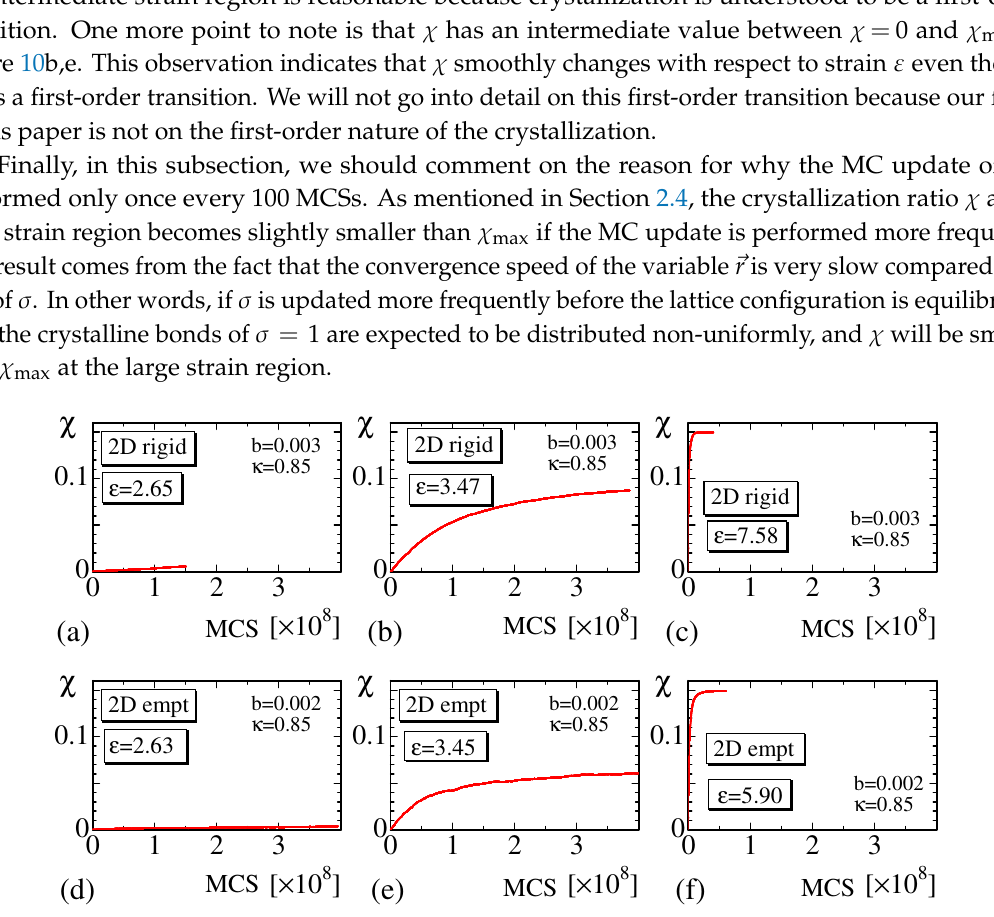
Figure 10. The crystallization ratio χ vs. Monte Carlo sweep (MCS) of the 2D rigid model obtained at ( a ) ε (cid:39) 2.65, ( b ) ε (cid:39) 3.47, and ( c ) ε (cid:39) 7.58, and the ratio χ vs. MCS of the 2D empty model at ( d ) ε (cid:39) 2.63, ( e ) ε (cid:39) 3.45, and ( f ) ε (cid:39)